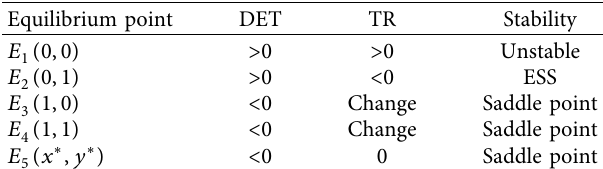
Table 4: Stability analysis of strategy system ( b ) of the government and enterprise.